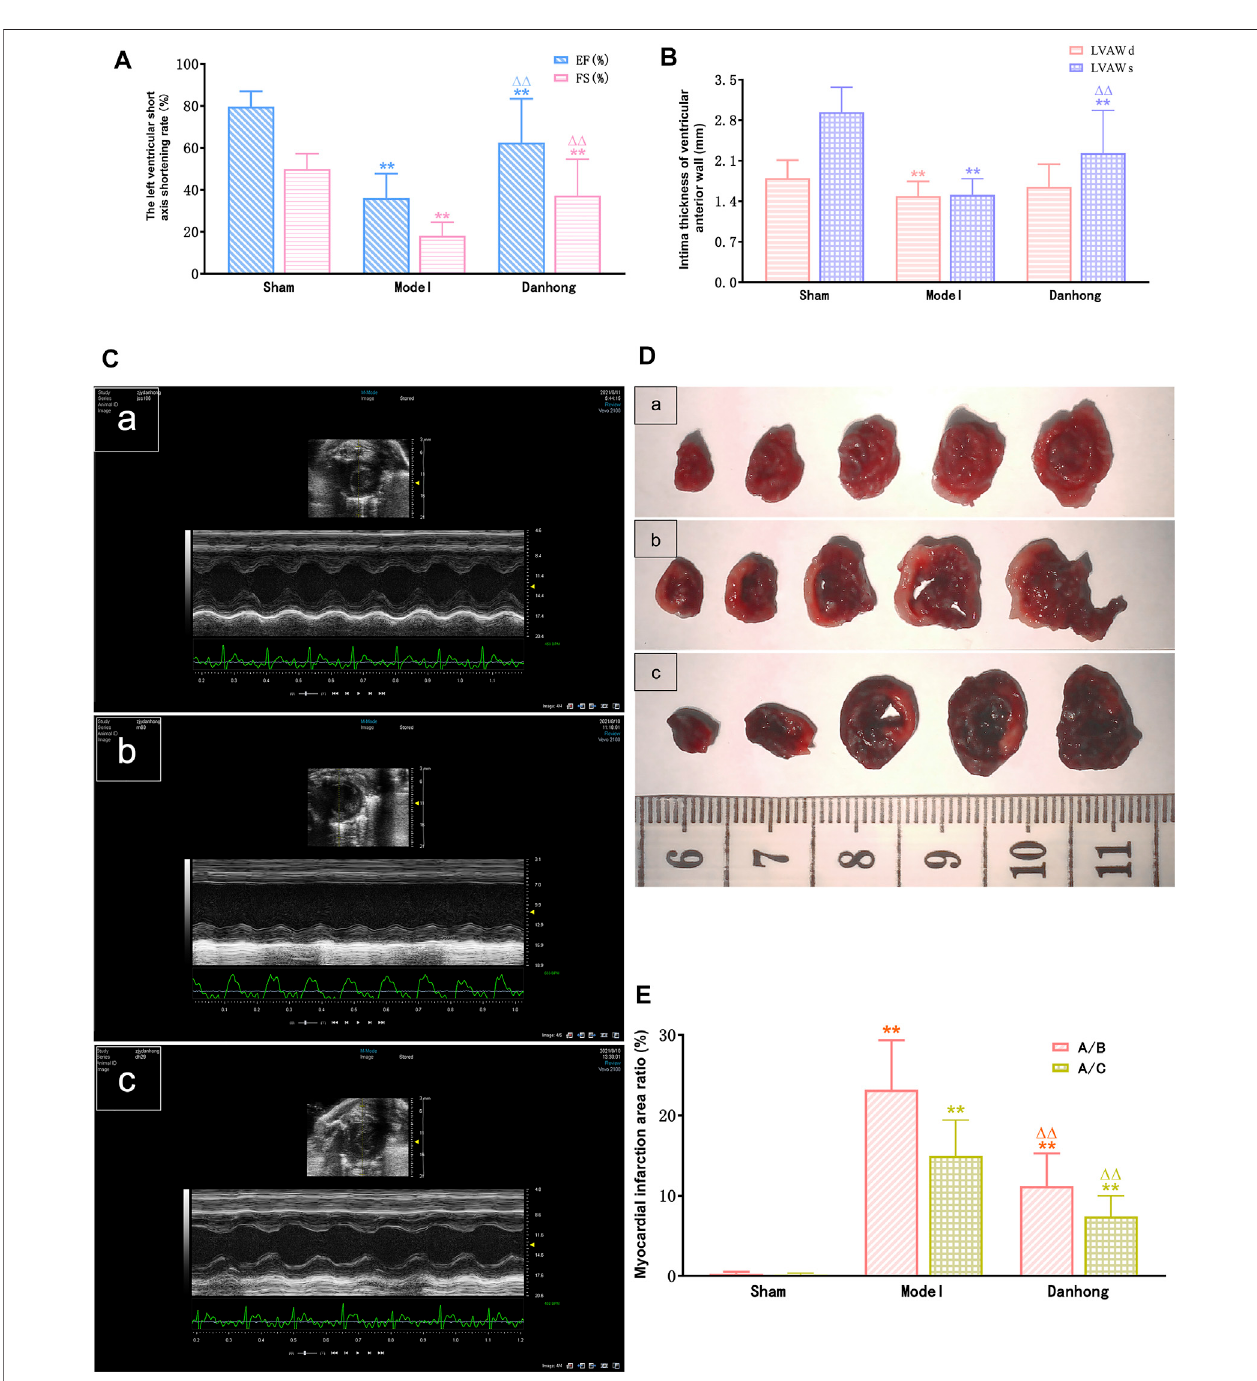
FIGURE 8 | (A) The effect of DHI on ejection fraction and left ventricular short axis shortening rate in AMI model rats ( (cid:1) x ±s). ** p < 0.01 vs. sham; △△ p < 0.01 vs. model. (B) The effect of DHI on end-diastolic and end-systolic ventricular intimal thickness of AMI model rats ( (cid:1) x ±s). ** p < 0.01 vs. sham; △△ p < 0.01 vs. model. (C) The effectofDHI on cardiac function inrats with AMI. a: sham group; b:model group; c:DHI 6 mg/kg group. (D) The effect of DHIon myocardialinfarction size in AMI model rats. a: sham group; b: model group; c: DHI 6 mg/kg group. (E) The effect of DHI on myocardial infarction size in AMI model rats ( (cid:1) x ±s). ** p < 0.01 vs. sham; △△ p < 0.01 vs.